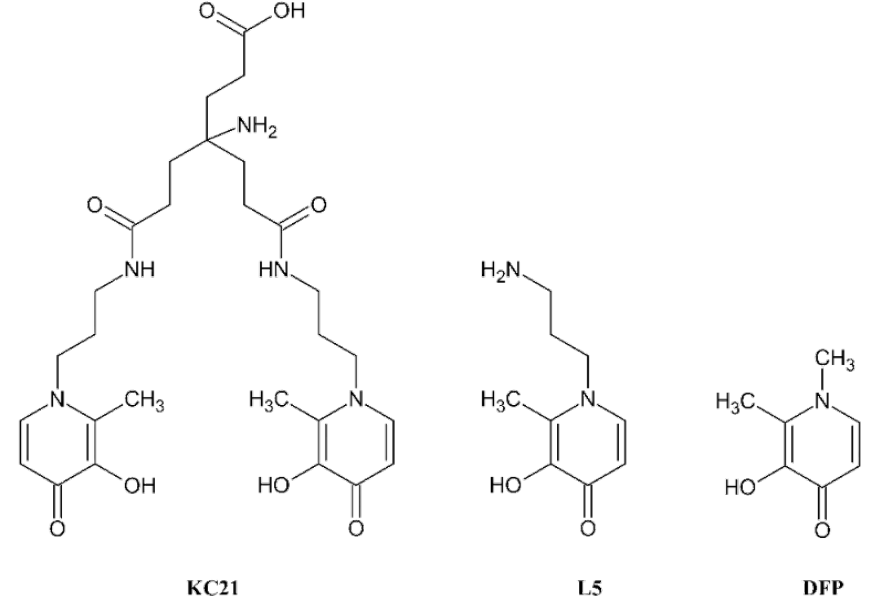
Figure 1. Chemical structures of the ligands KC21, L5 and DFP.